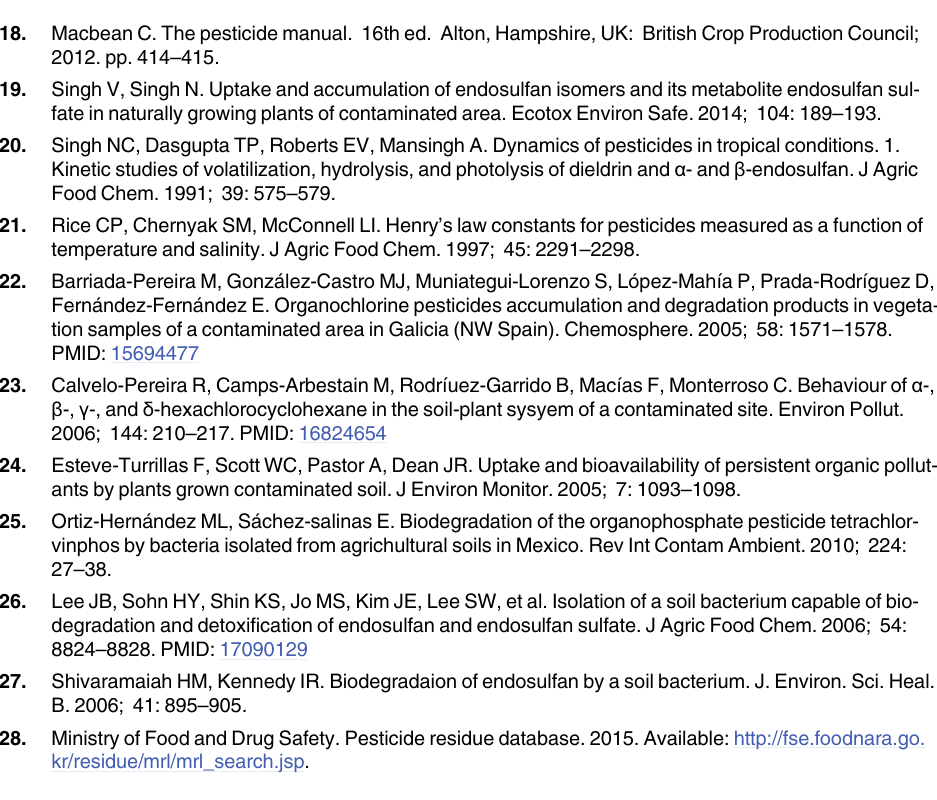
PLOS ONE | DOI:10.1371/journal.pone.0141728 November 3,